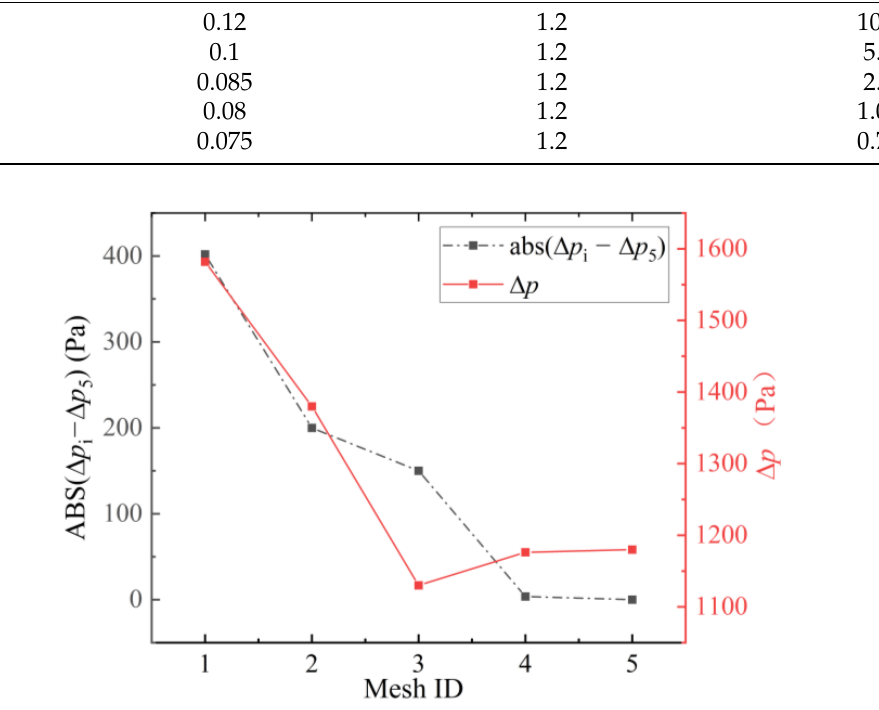
Figure 4. The comparison between different meshes.